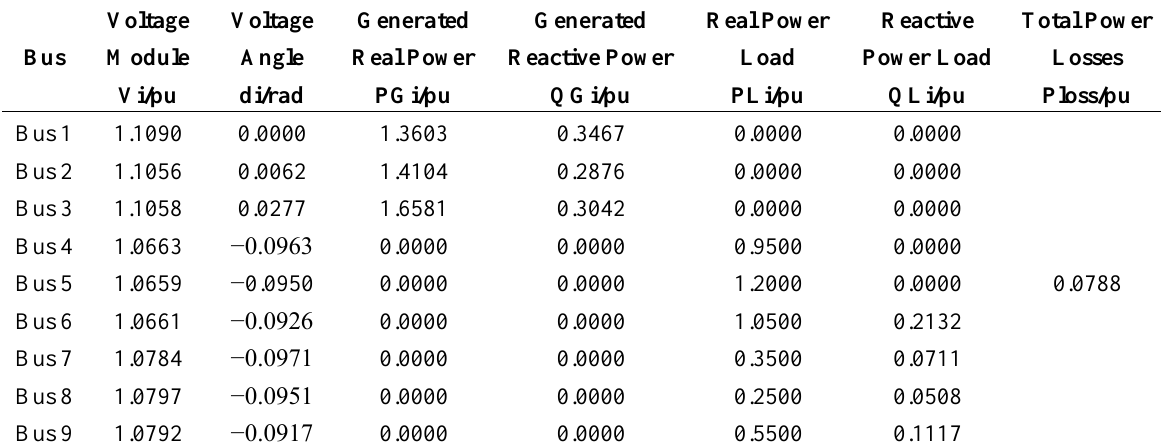
Table 12. The behavior of the test system with OOP.